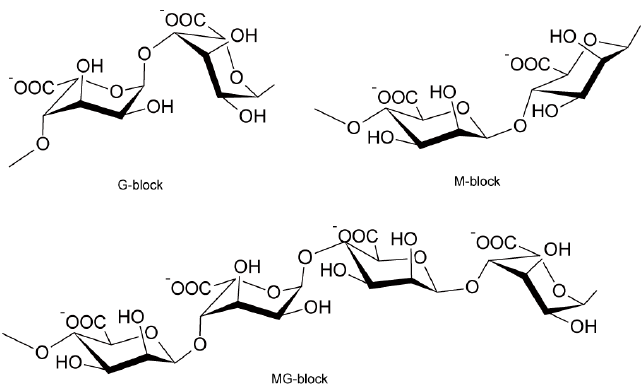
Figure 1. Structure of alginate [3]. G-block: guluronic acid residues; M-block: mannuronic acid residues; MG-block: alternating mannuronic acid and guluronic acid residues.